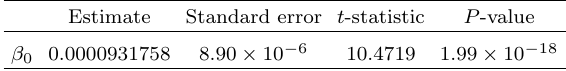
Table A.5. Regression results for model